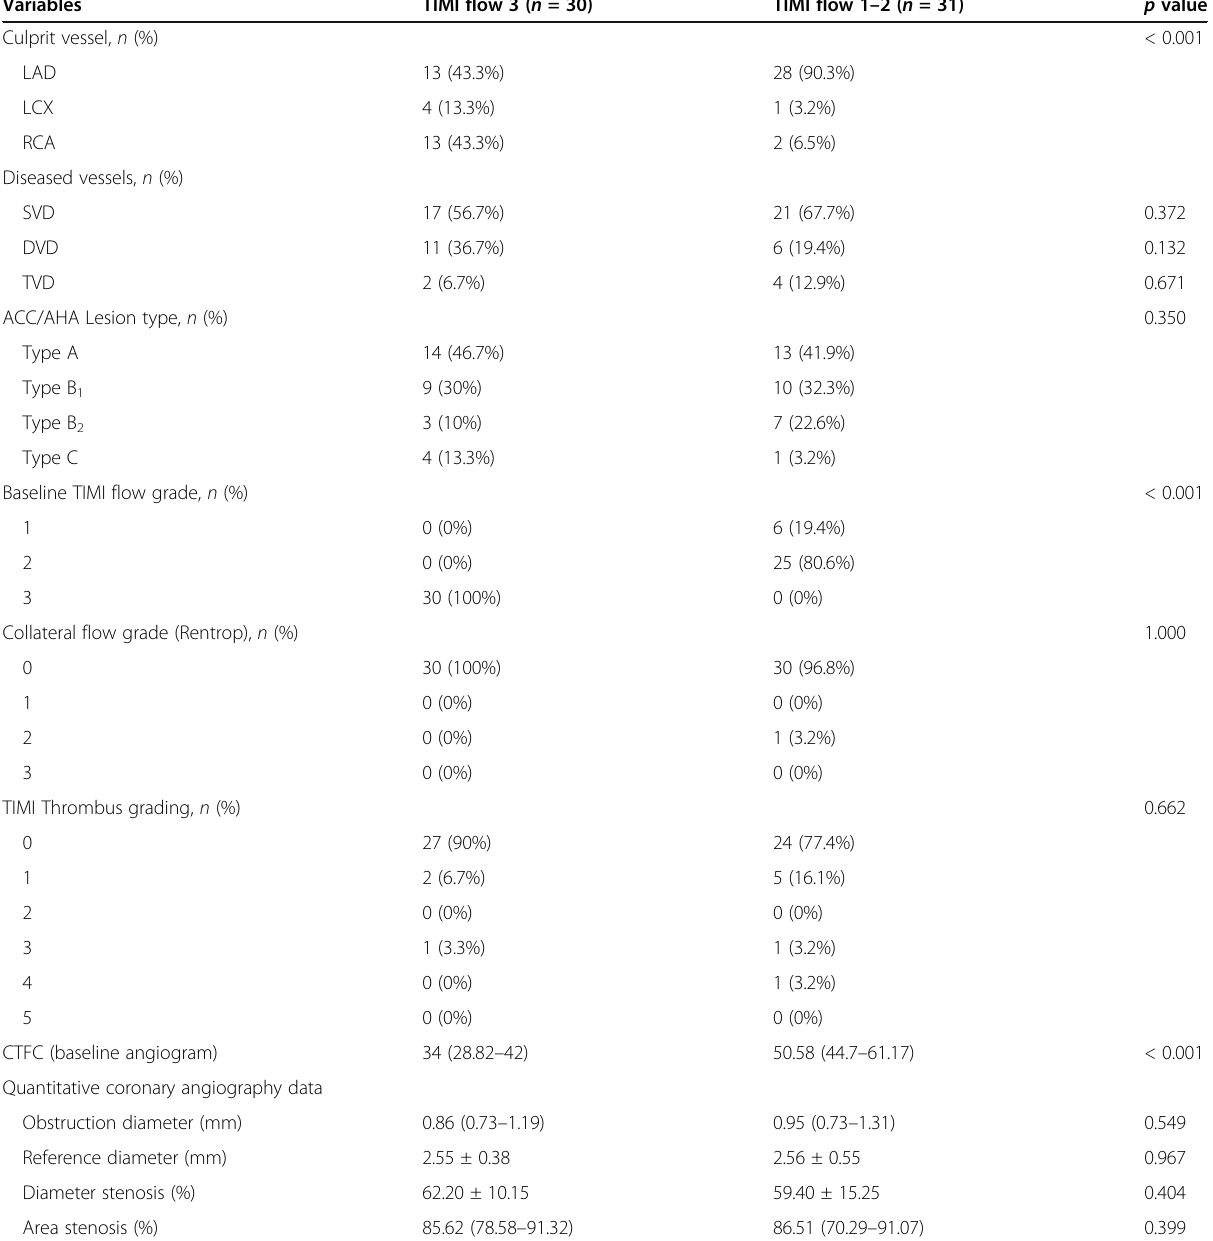
Table 2 Angiographic characteristics and procedure findings ( n = 61)